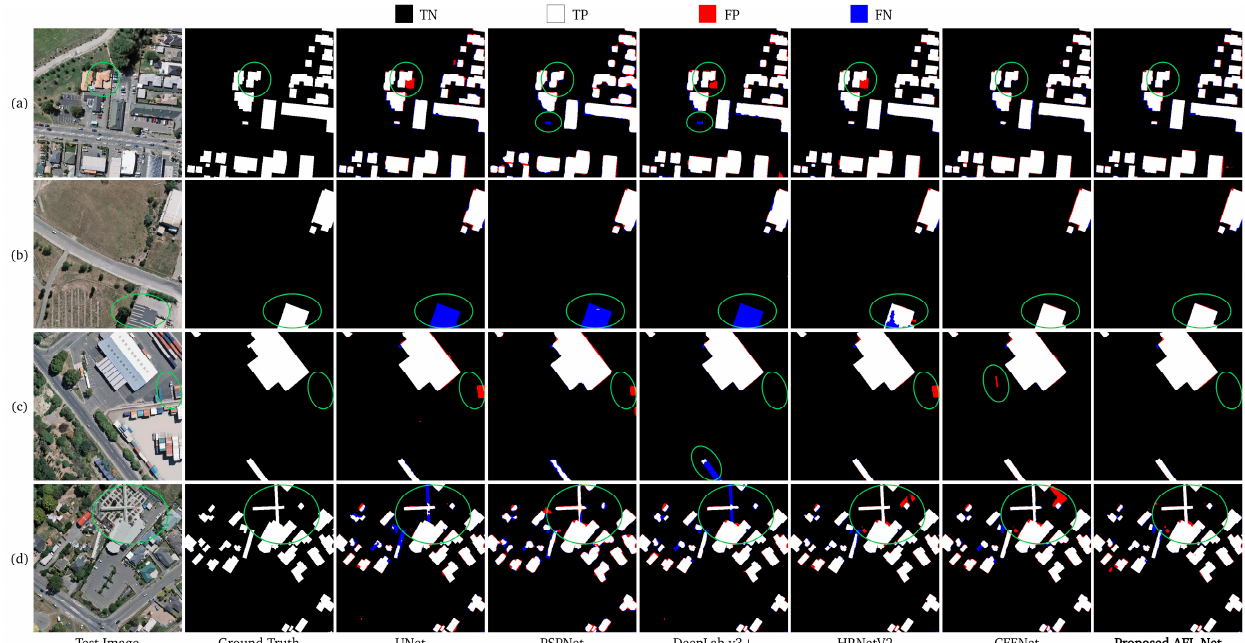
Figure 9. Sample building segmentation results from the selected models with the WHU dataset (comparative experiment).